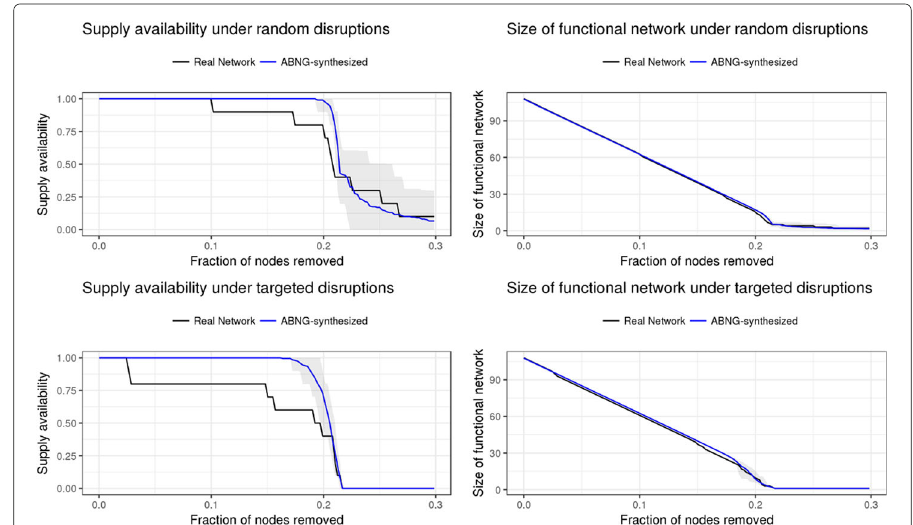
Fig. 5 Supply network of semiconductors and related devices